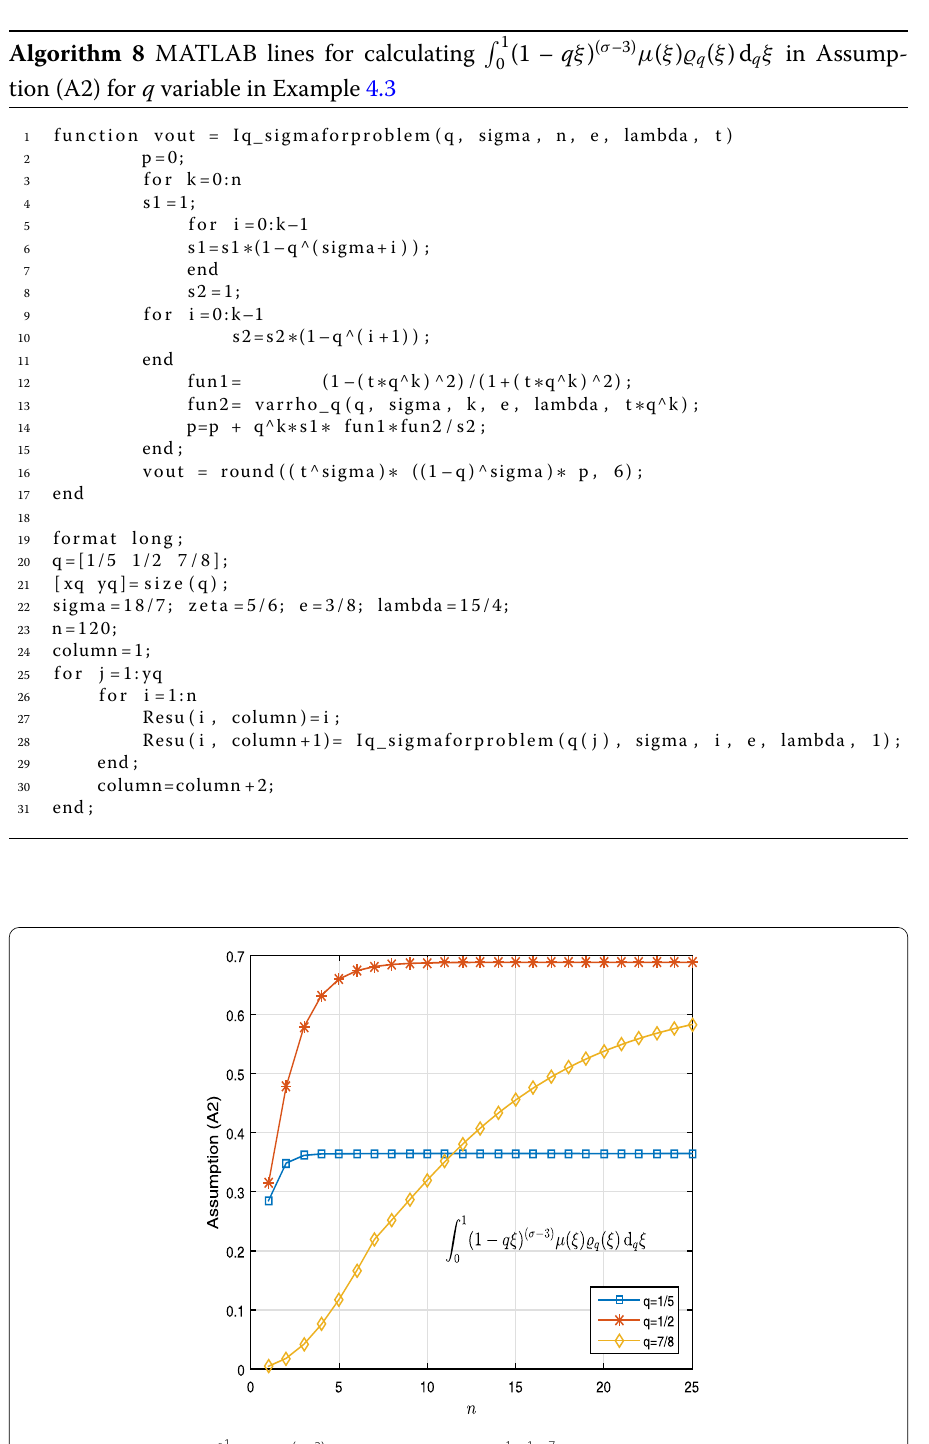
, 1 , 7 in Example 4.3 5 2 8